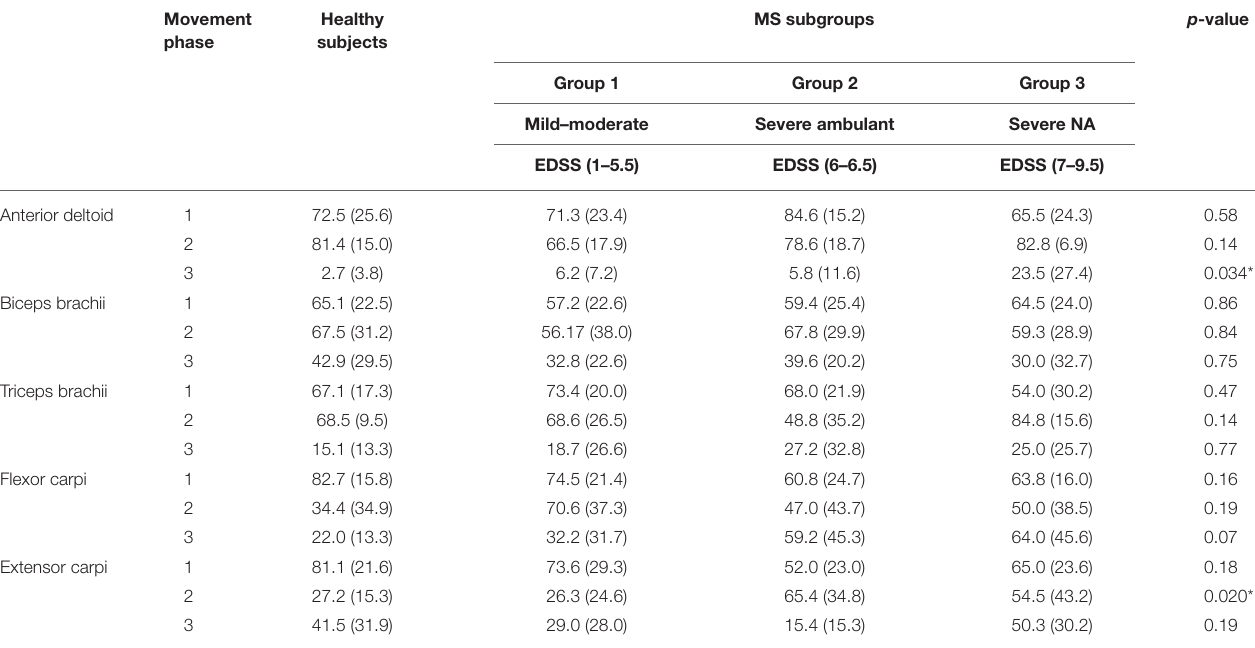
TABLE 3 | Mean (standard deviation) of timing maximal muscle